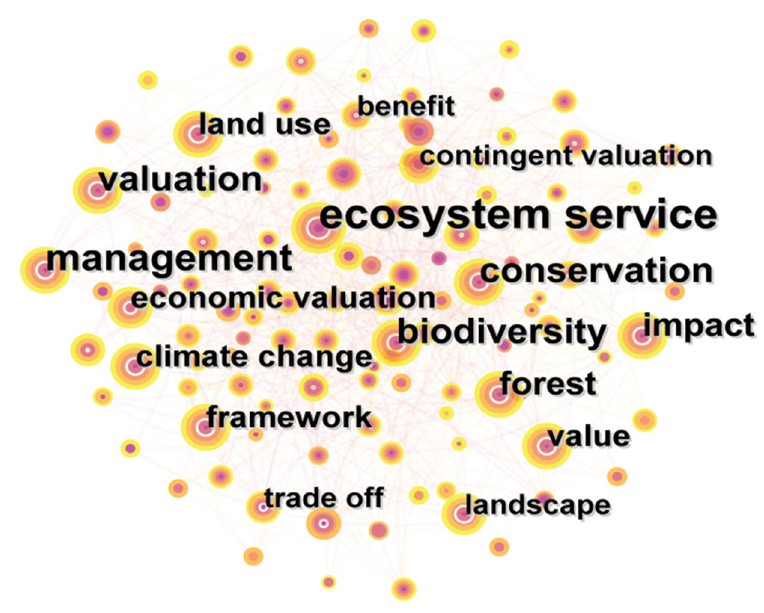
Figure 5. Keyword co-occurrence network. Table 1. Keyword frequency statistics.